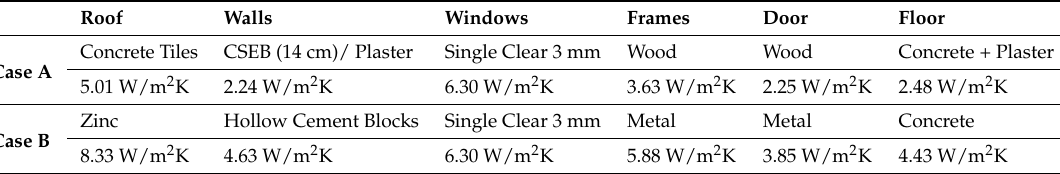
Table 1. Case A and Case B envelope